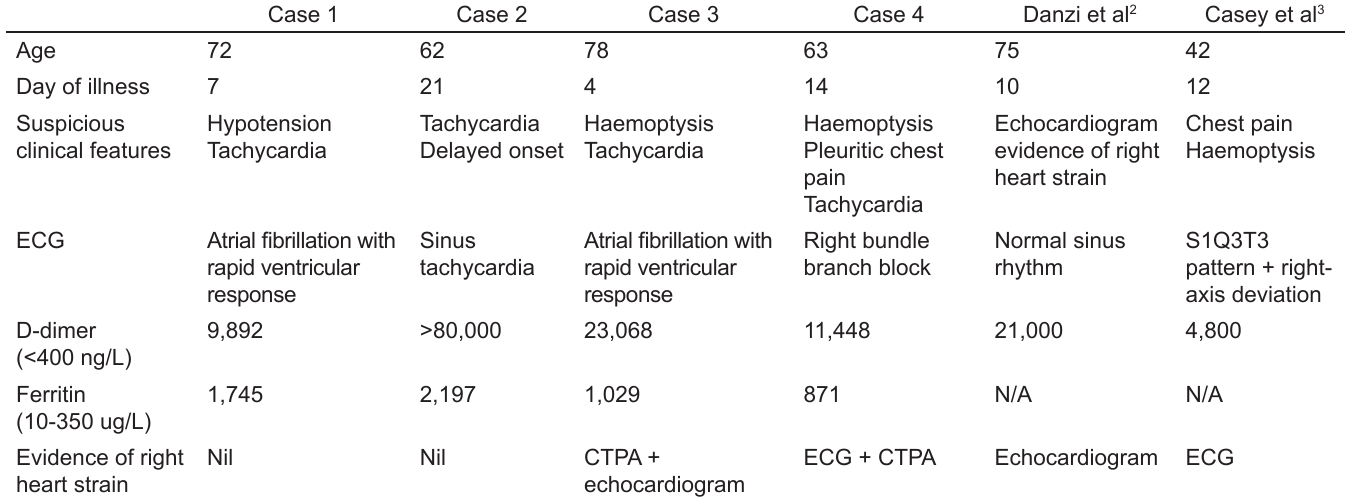
Table 2. Age, day of illness, suspicious clinical features, electrocardiogram findings, D-dimer value, ferritin value, and evidence of right heart strain in cases 1-4 and 2 cases in the literature.